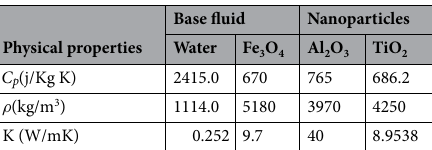
Table 2. Thermophysical properties of the base fluid and the nanoparticles 58